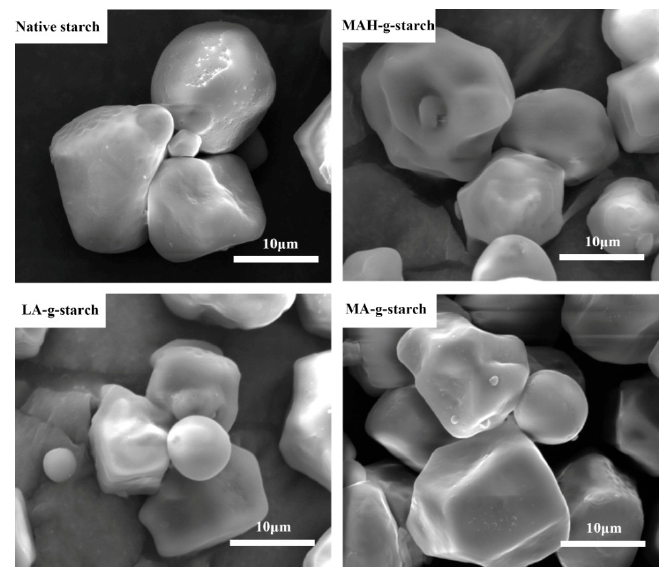
Figure 6. SEM images of native starch and grafted starches.